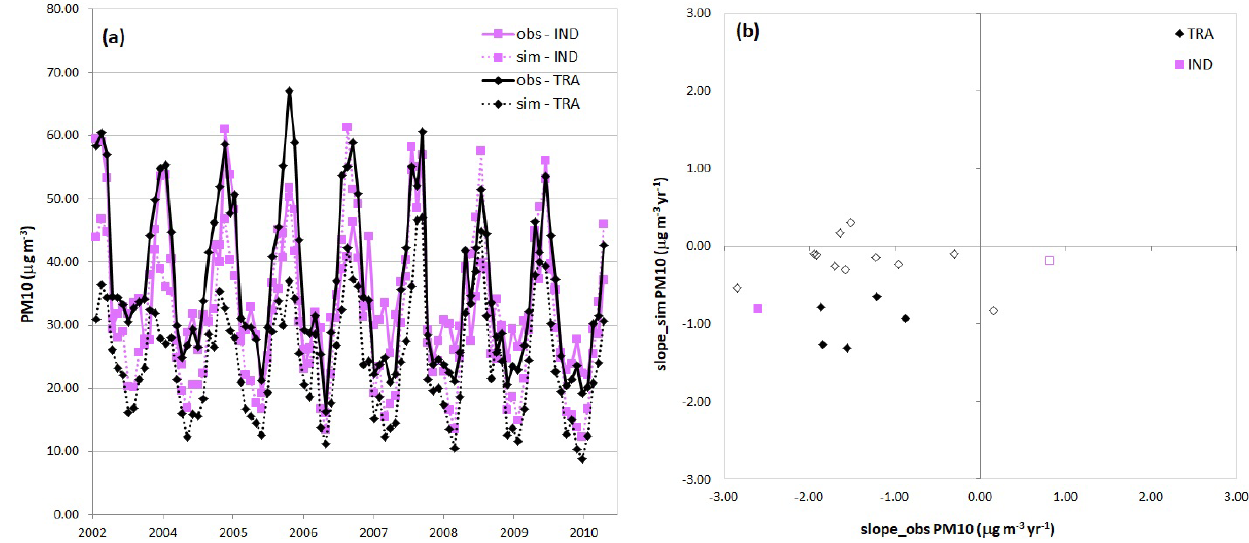
Figure 9. (a) Observed (solid line) and simulated (dashed line) monthly means of PM 10 concentrations (in µgm − 3 ) for all the traffic (black diamond) and industrial (pink square) monitoring stations. (b) Scatter plot of observed and simulated slopes (in µgm − 3 yr − 1 ) at each individual station. Sites where significant slopes are estimated for both observations and simulated data are indicated with a filled